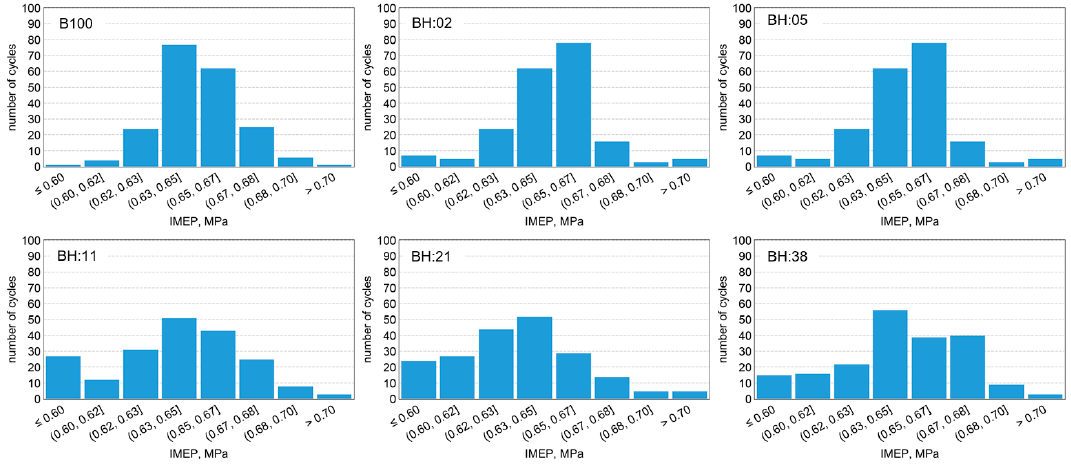
Figure 7. Distribution of indicated mean effective pressure (IMEP) for different energy shares of hydrogen.